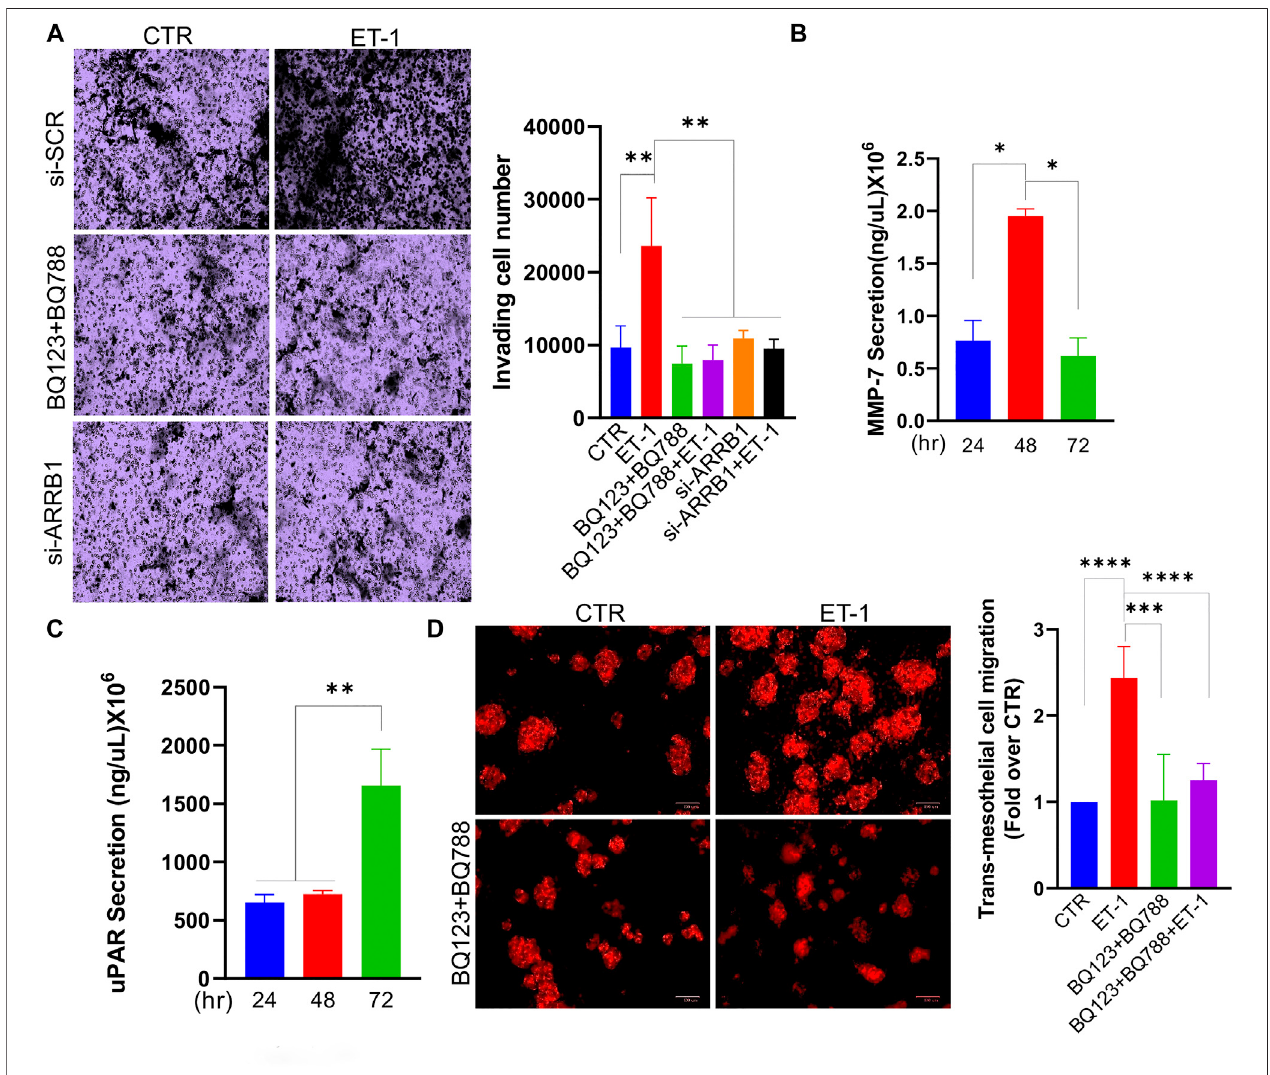
FIGURE 8 | ET-1 promotes invasion of MCs and transmesothelial migration of SOC cells. (A) Transwell invasion assays of MCs transfected with si-SCR or si- ARRB1and stimulated with ET-1and/or BQ123+BQ788 for12 h. Histograms,themean ± SD, n (cid:2) 6.One-way ANOVA. (B) MMP-7or (C) uPARsecretion evaluatedby ELISA in CM from MCs at indicated times. Histograms, the mean ± SD, n (cid:2) 2. One-way ANOVA. (D) Transmesothelial migration assay of OVCAR3 cells seeded into the upper chamber with a monolayer of MCs on a fi bronectin-coated membrane and treated with ET-1 and/or BQ123+BQ788 for 24 h. Histograms, the mean ± SD, n (cid:2) 6. One-way